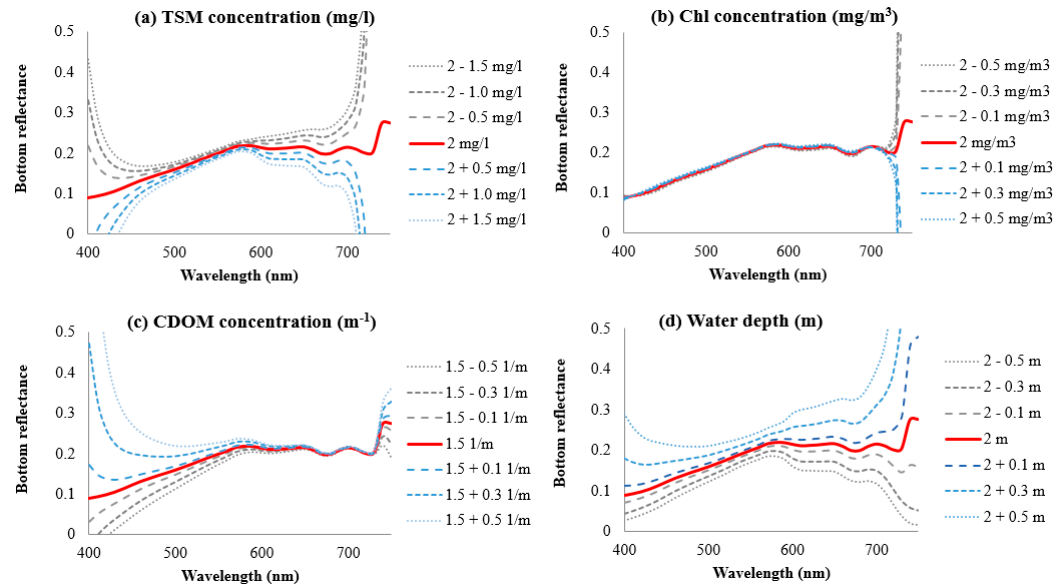
Figure 6. Lee model’s sensitivity to input parameters in retrieving sand substrate from water surface reflectance. Correct model input parameters include C Chl = 2 mg/m 3 , C TSM = 2 g/m 3 and a CDOM = 1.5 m − 1 , depth = 2 m. Retrieved substrate spectra are affected by ( a ) total suspended matter concentration (TSM) variations, ( b ) chlorophyll-a (Chl) concentration variations, ( c ) colored dissolved organic matter (CDOM) concentration variations and ( d ) water depth variations.